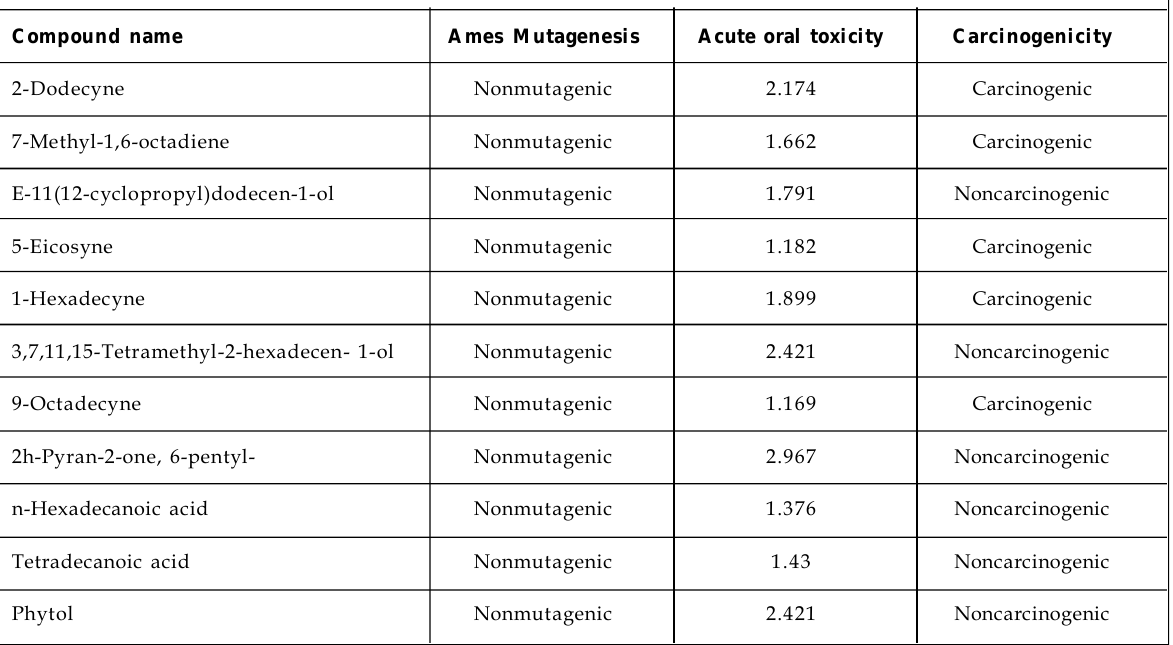
Table 3: Assessment of toxicity and carcinogenicity of the